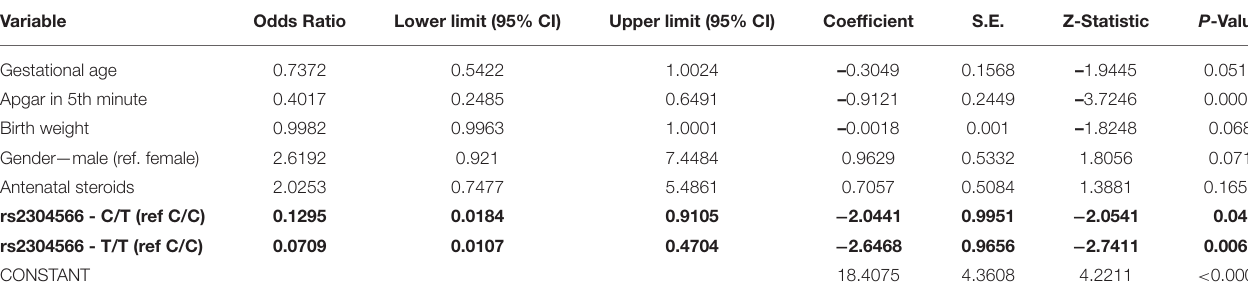
TABLE 6 | Logistic regression analysis (model